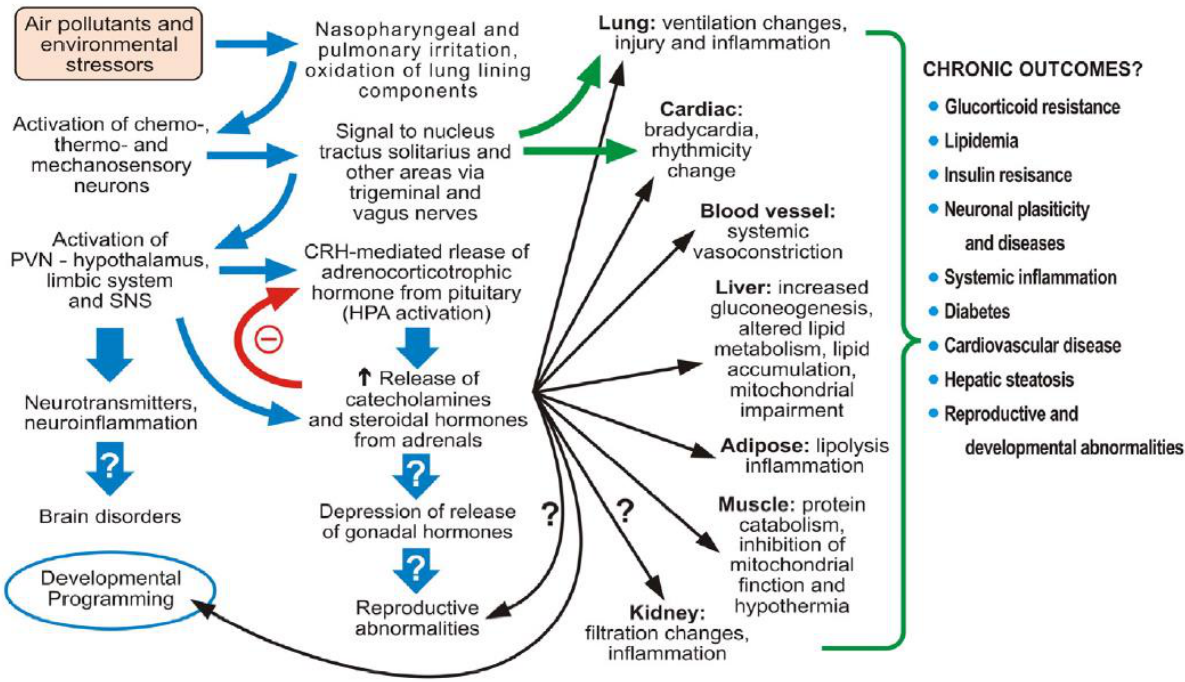
Figure 5. Effects of particulate matter on different components of the atmosphere. Reprinted with permission from ref. [35]. Published by Elsevier B.V. Copyright © 2016 Elsevier Ltd. All rights